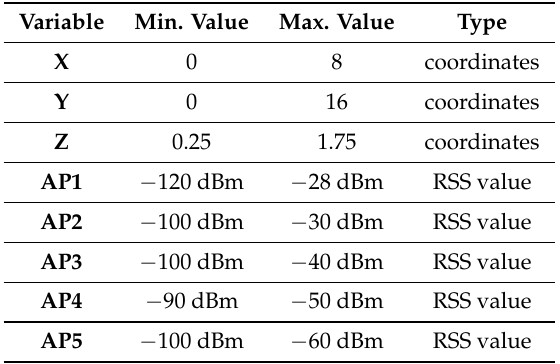
Table 3. The features used to construct the fingerprints database.